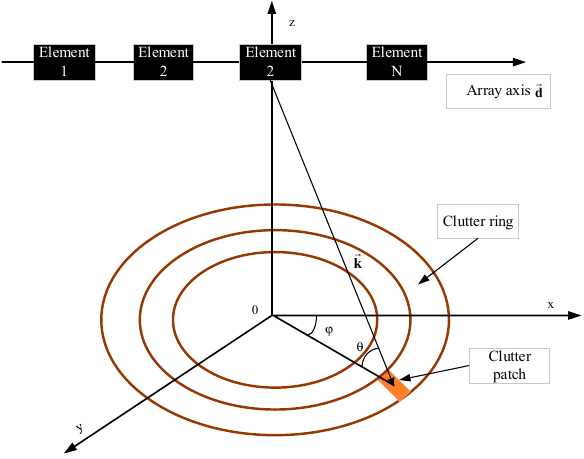
Figure 1. Geometric configuration of an airborne radar.